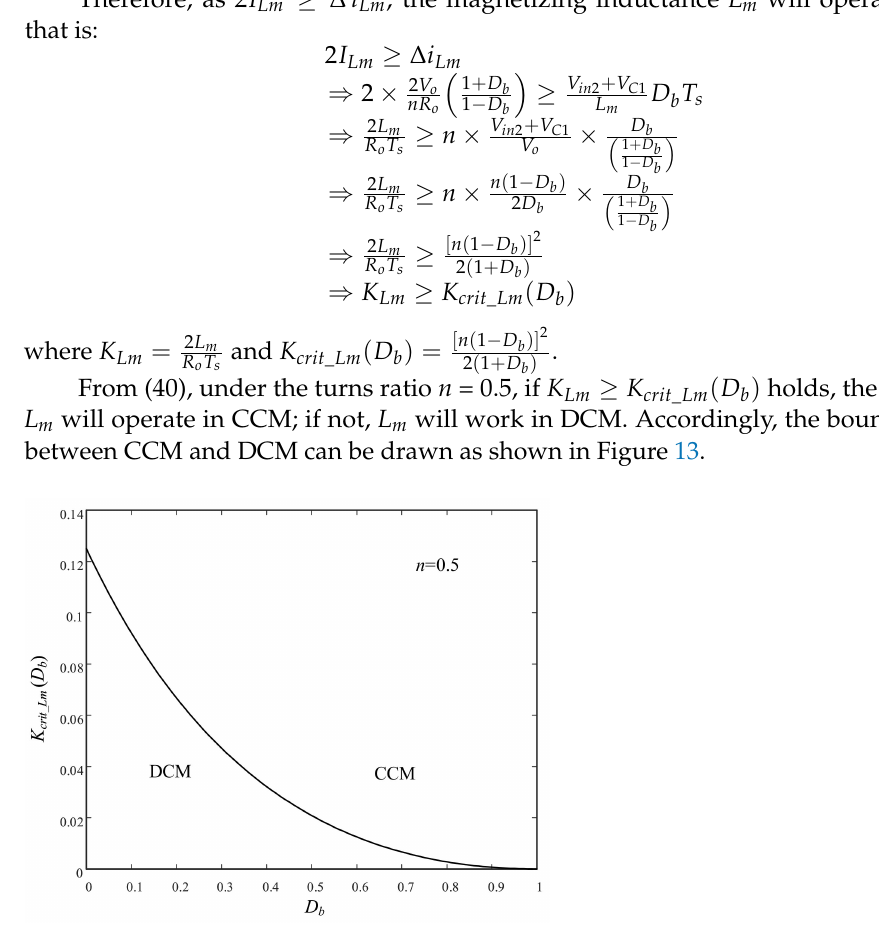
Figure 13. Boundary curve between CCM and DCM for L m